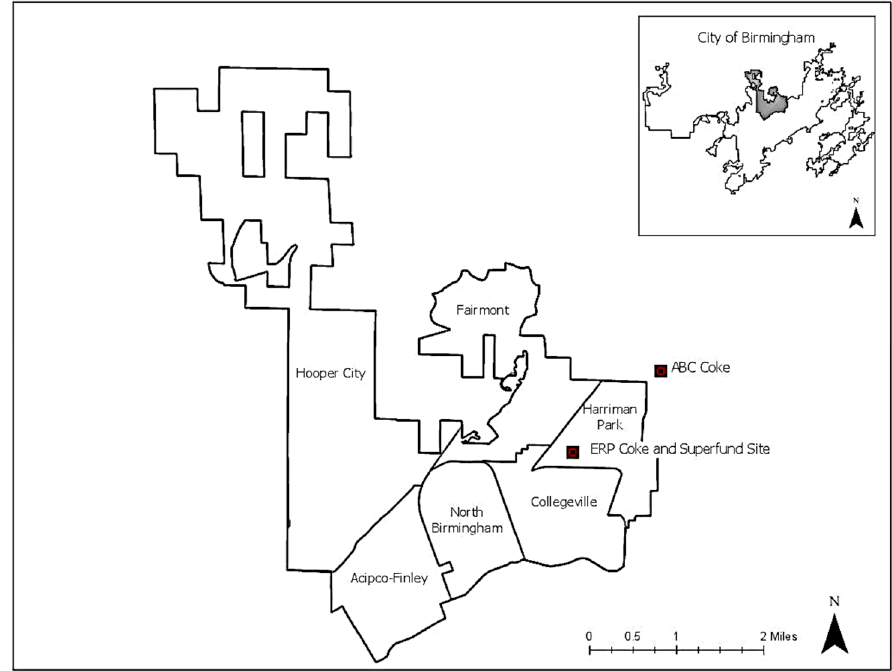
Figure 1. North Birmingham neighborhoods and coke plants.